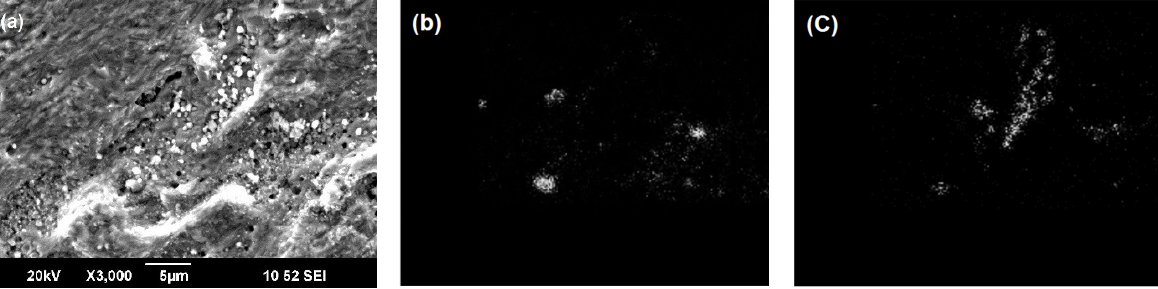
Figure 3: Alloy Cu-0.55Cr-0.2Cd-0.02Zr after eight ECAP cycles: a–structure (SEM); b–Cr distribution pattern; c–Zr distribution